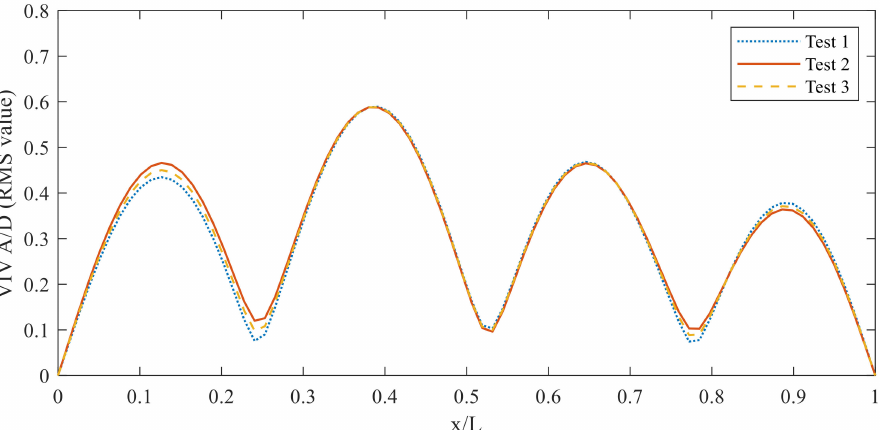
Figure 14. RMS value of VIV nondimensional displacement (A/D) for repeated tests (F01, U = 2.0